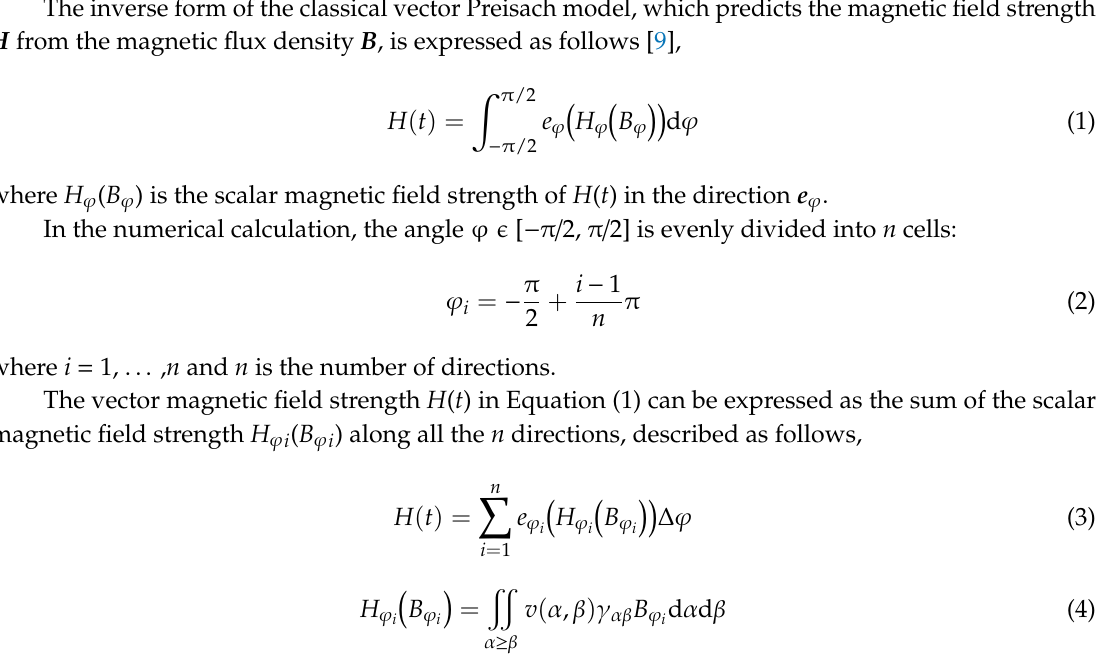
Figure 4. Measured concentric hysteresis loops in two orthogonal directions: ( a ) In x direction; ( b ) In y direction.